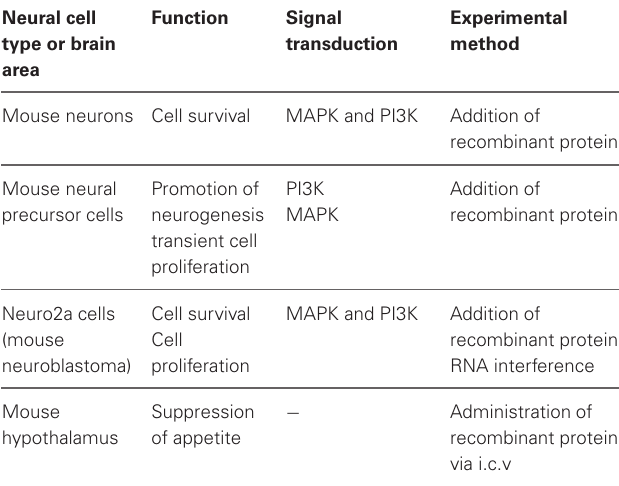
Table 1 | Functions of